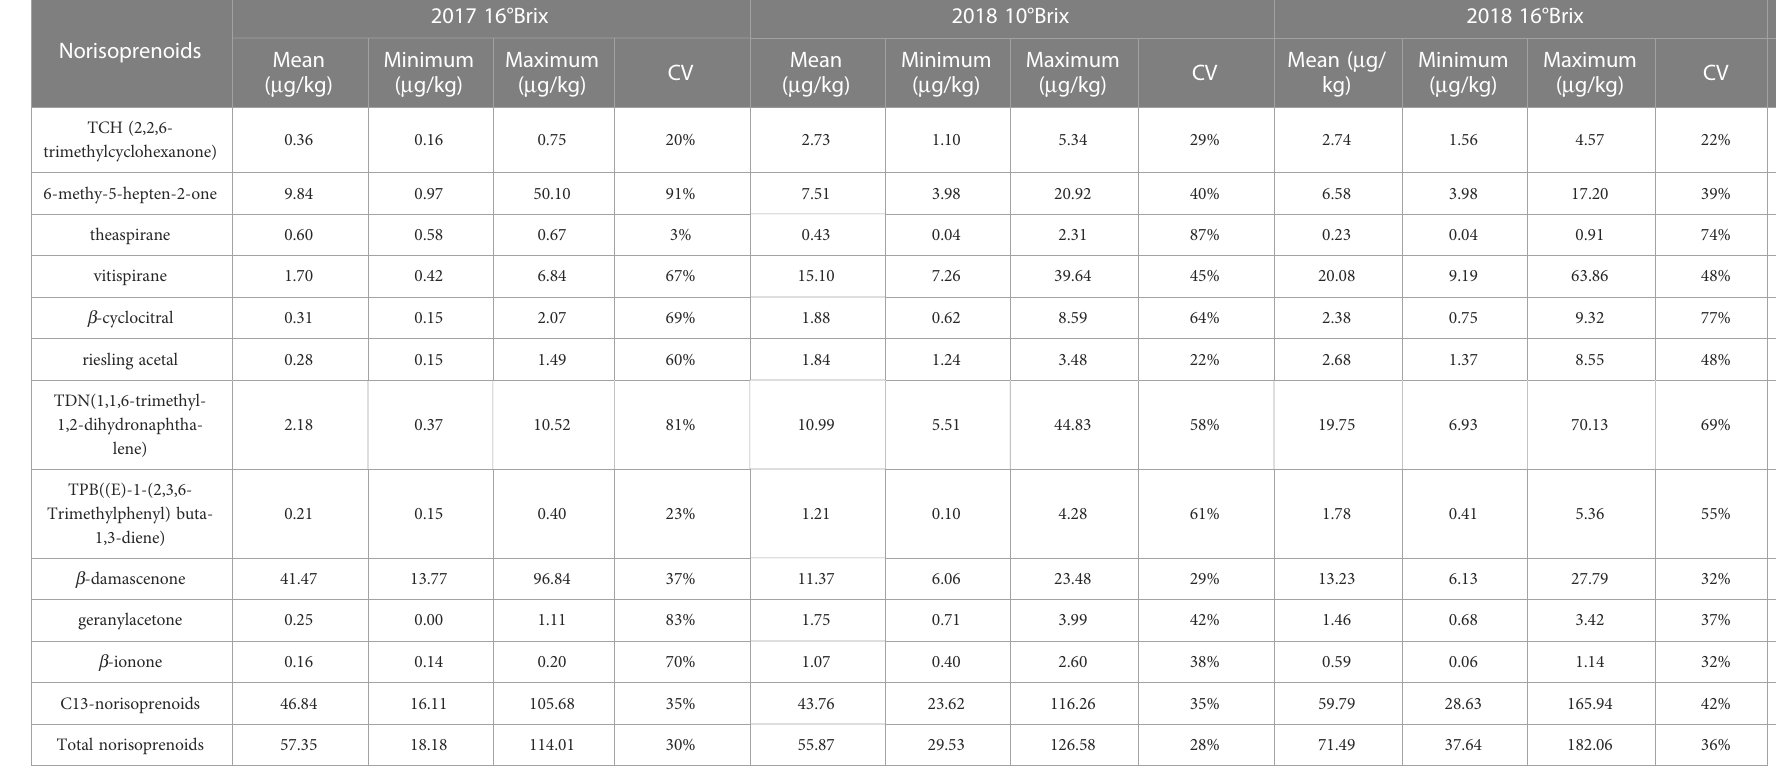
TABLE 2 Statistical analysis of norisoprenoids concentrations in the F 1 hybrid population.